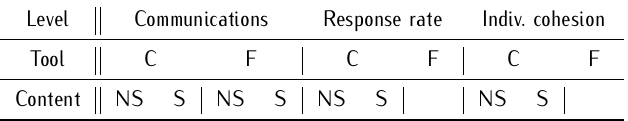
Table 1. Level of analysis of Communications, Response rate and Individual cohesion. Where C means Chat, F means Forum, NS means Non-social and S means Social Level Communications Response rate Indiv.